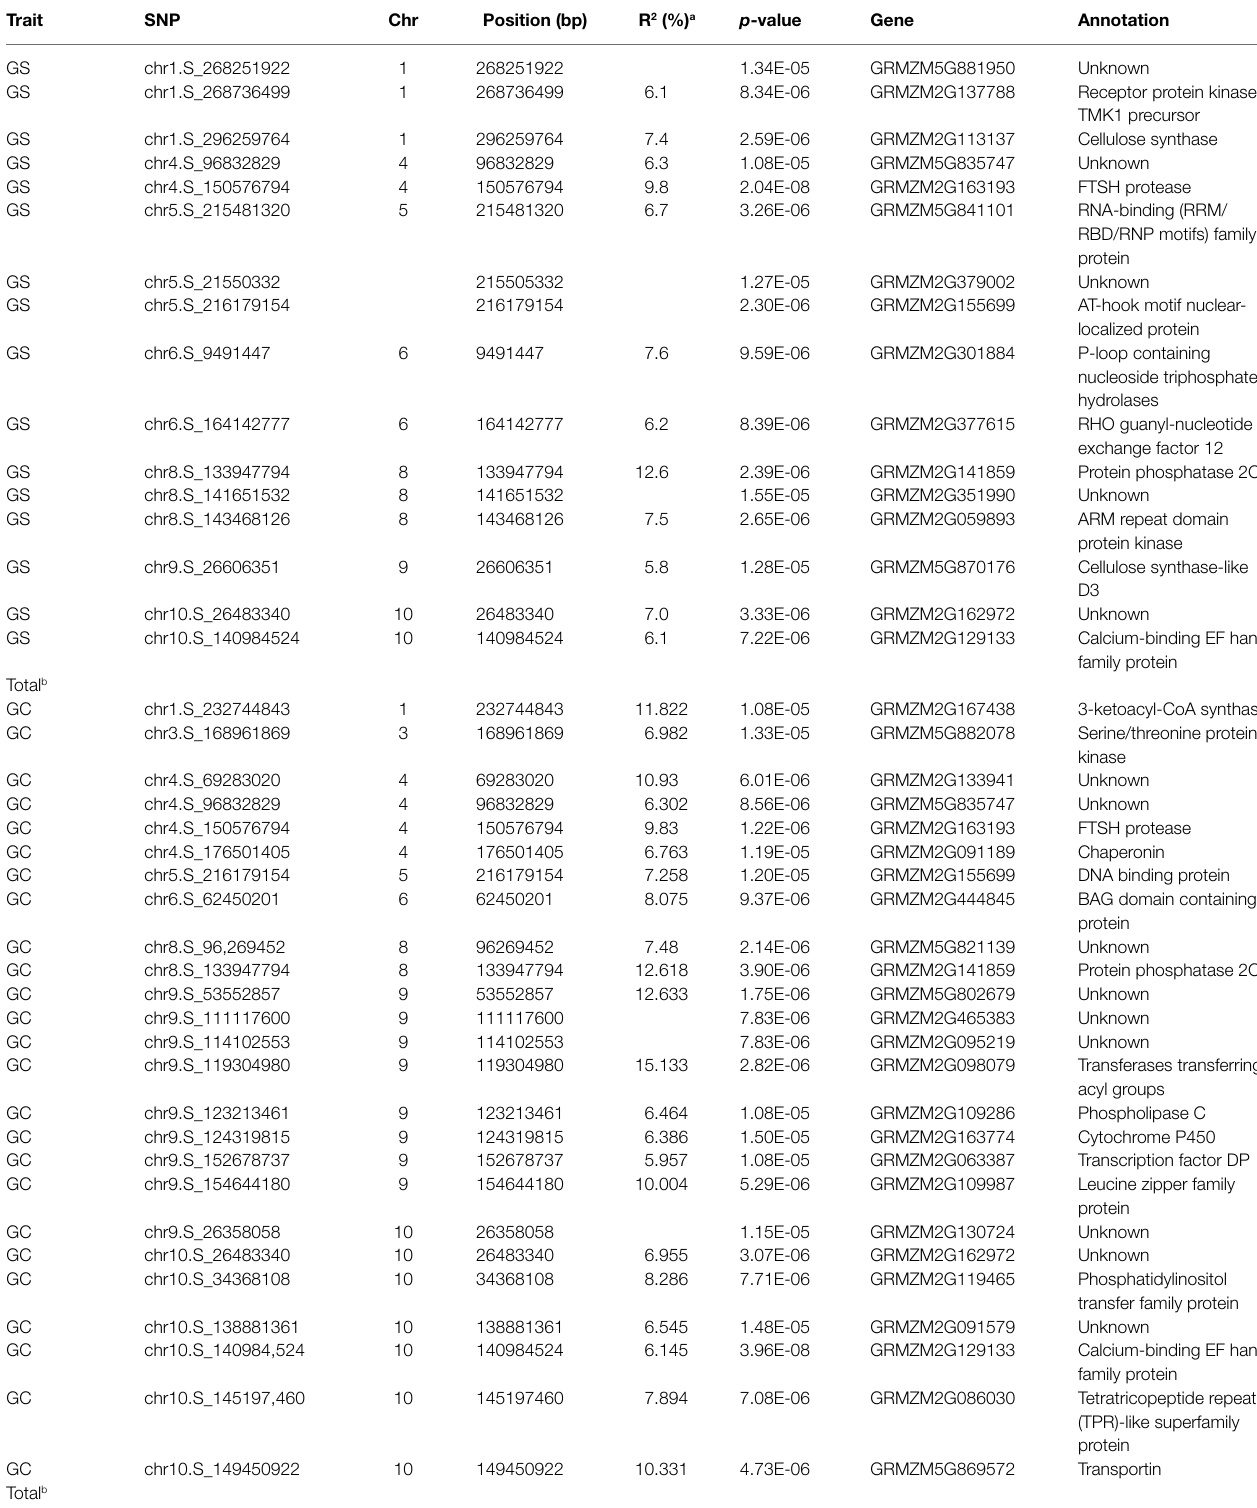
TABLE 2 | SNP chromosomal positions and candidate genes are significantly associated with germination traits identified by GWAS.